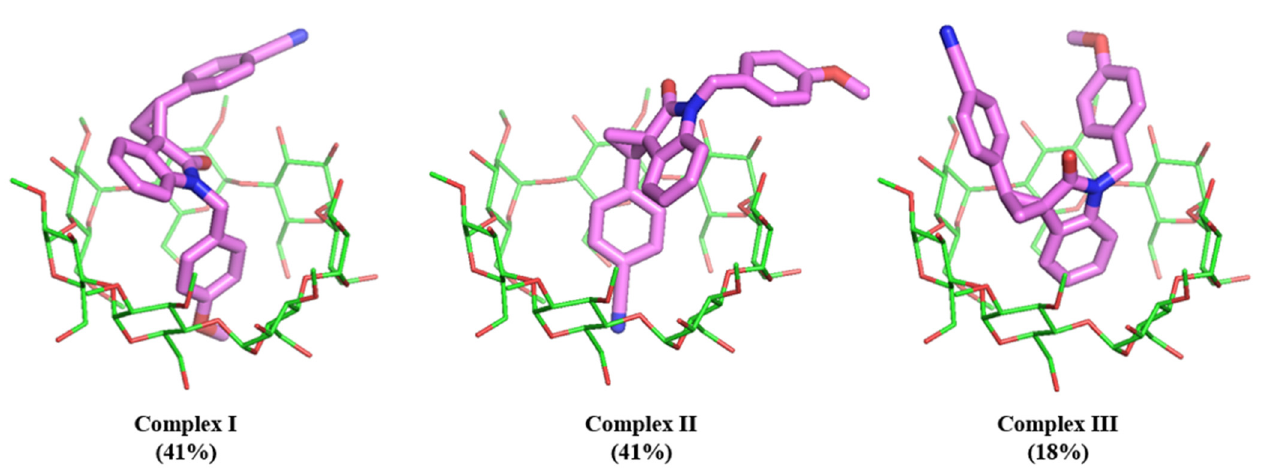
Figure 11. Three predicted M β CD- 2b complex types.